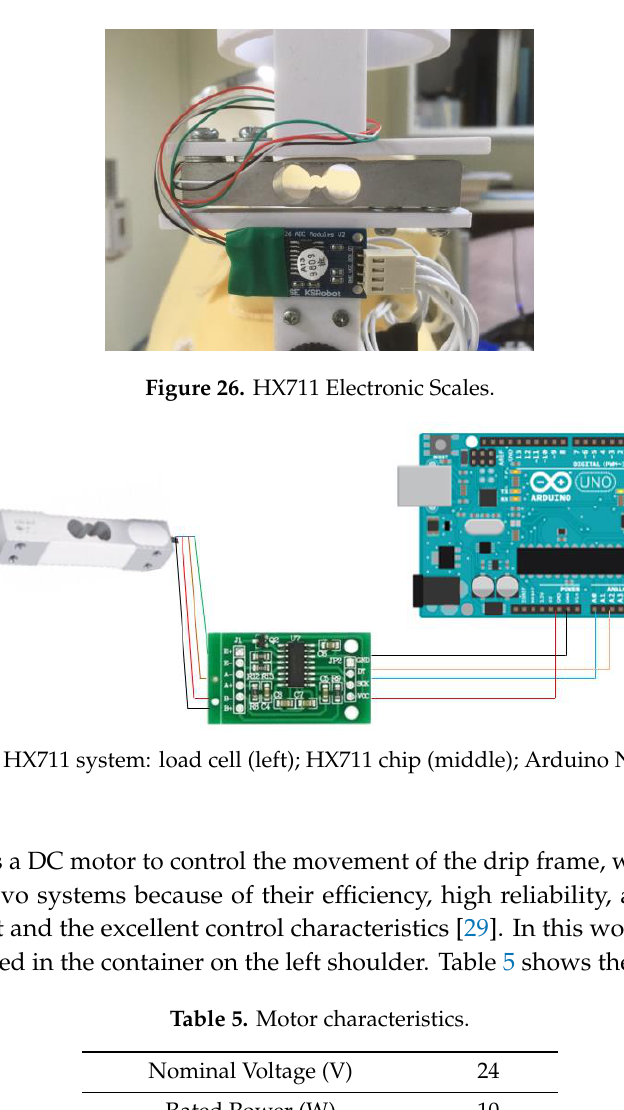
Table 5. Motor characteristics.